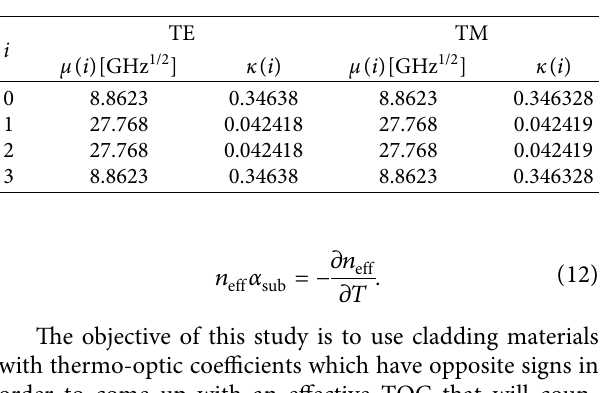
Figure 2: (a) Waveguide cross section. (b) Schematic of the diferent layers of the 3D view of the graphene-coated waveguide. Te optimal dimensions of the cross-section are W � 650nm, H � 75 nm, h � 15nm, and r � 3.4nm. Table 2: Apodized energy coupling coefcients ( μ ( i )) and feld ( κ ( i )) coupling coefcients of a 50 GHz-bandwidth and 3.7 nm-FSRthird-order